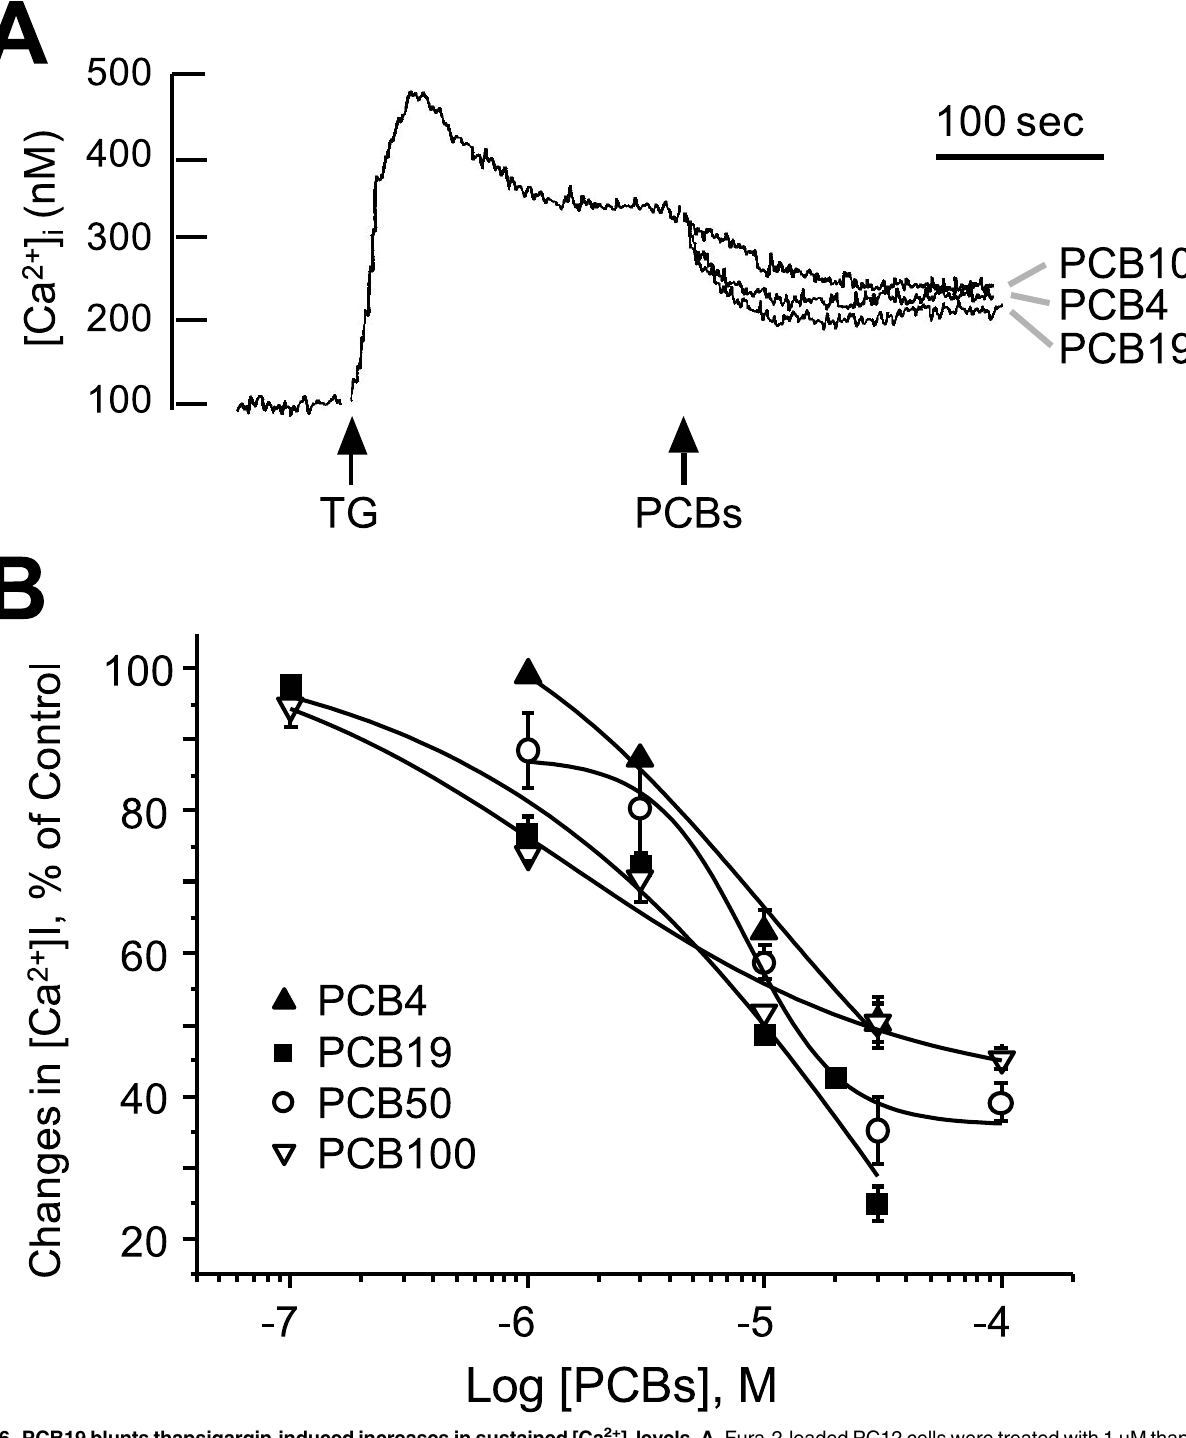
Fig 6. PCB19 blunts thapsigargin-induced increases in sustained [Ca 2+ ] i levels. A , Fura-2-loaded PC12 cells were treated with 1 μ M thapsigargin; 5 minutes later (at the sustained phase), cells were challenged with 50 μ M of either PCB4, PCB19, or PCB100. Data presented include typical Ca 2+ traces from more than five independent experiments. B , Concentration-dependent effects of PCBs on thapsigargin-induced SOCE. Decreases in Ca 2+ levels were monitored upon stimulation with various concentrations of PCB4 (filled triangles), PCB19 (filled squares), PCB50 (blank circles), and PCB100 (blank triangles). Net decreases in [Ca 2+ ] i are expressed as % of controls (thapsigargin-induced Ca 2+ levels without PCB19 treatment). Each point shown was obtained from triplicate experiments and represents the mean ± SEM. TG,